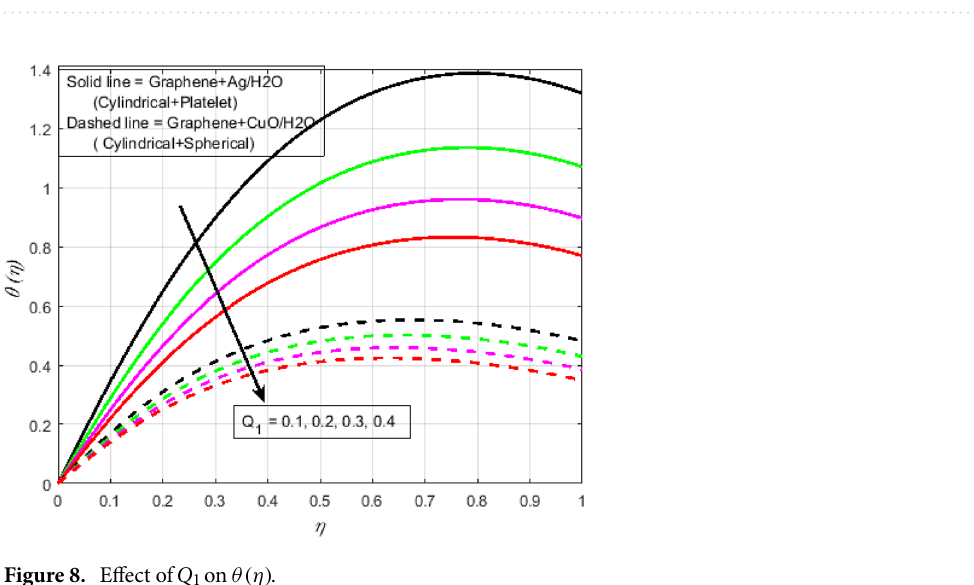
Figure 7. Effect of N r on θ(η) .